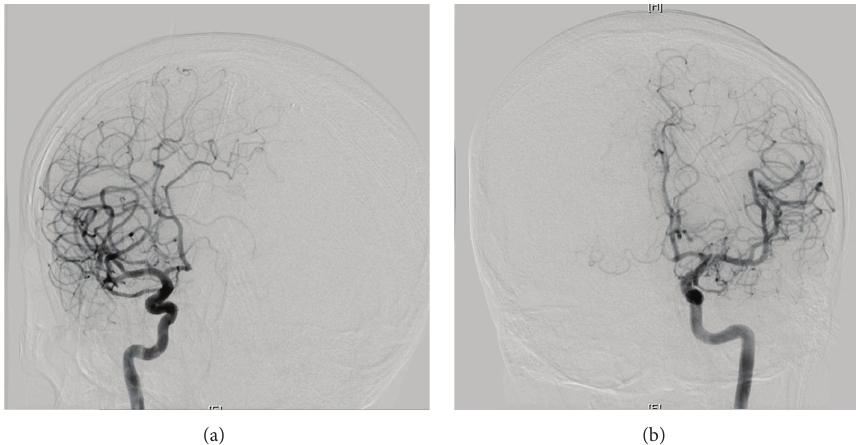
Figure 5: Diagnostic cerebral angiogram 10 months after radiation treatment. (a) AP right carotid injection. (b) AP left carotid